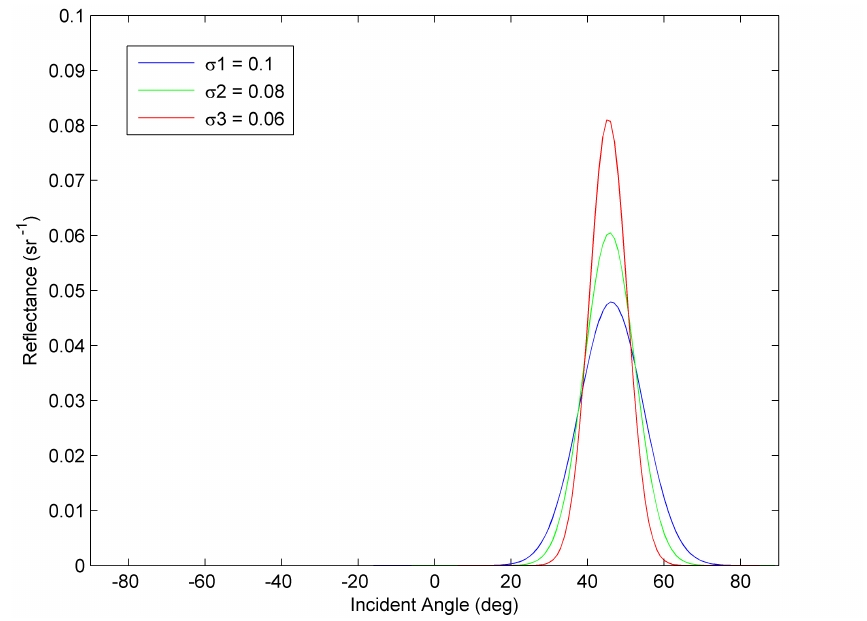
Figure 3. Diagram of the Cook-Torrance model (reflectance vs. incident